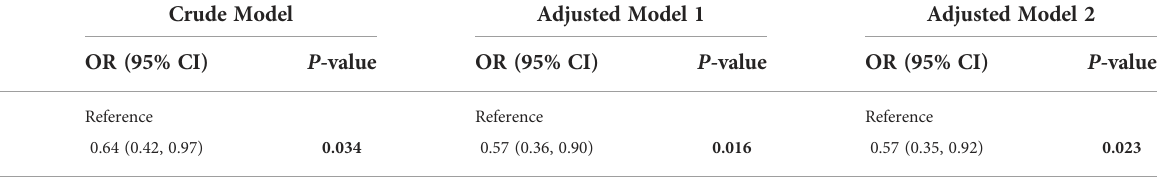
TABLE 3 Correlation between live birth and endometrial preparation (NC or HRT) in different models.